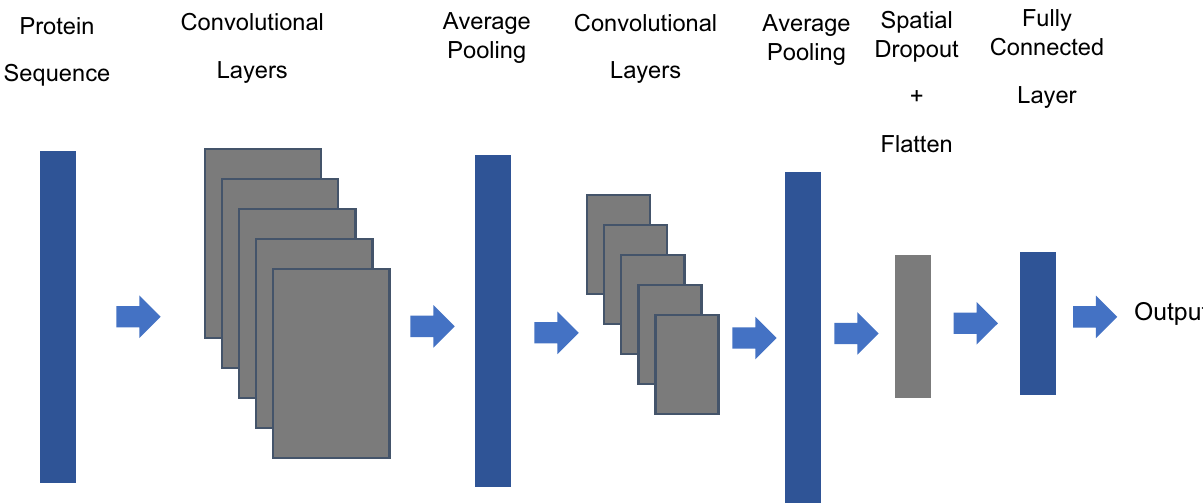
Figure 2. Outline of the model: the encoded protein sequence is fed to convolutional layers with 25 filters of dimensions 1 × 100. The second set of convolutional layer filters have dimensions 1 × 50. ReLU was used as the activation function. Mean squared error was the metric used as the loss function. The pooling layers had a pool size of 5, and the dropout layer had a factor of